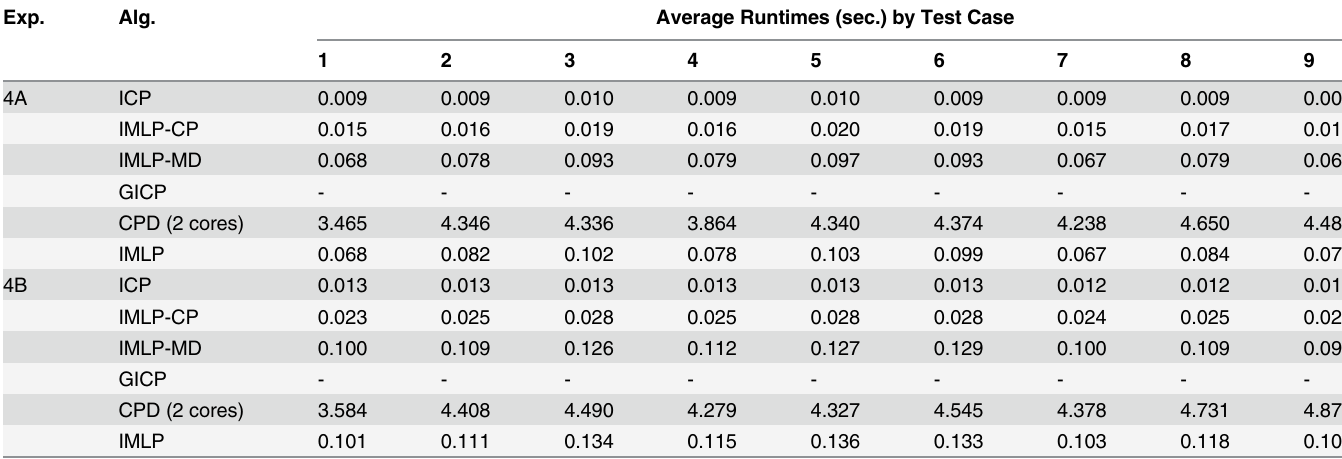
Table 9. Runtimes for registering a point-cloud target shape. (Experiment 4). Exp.